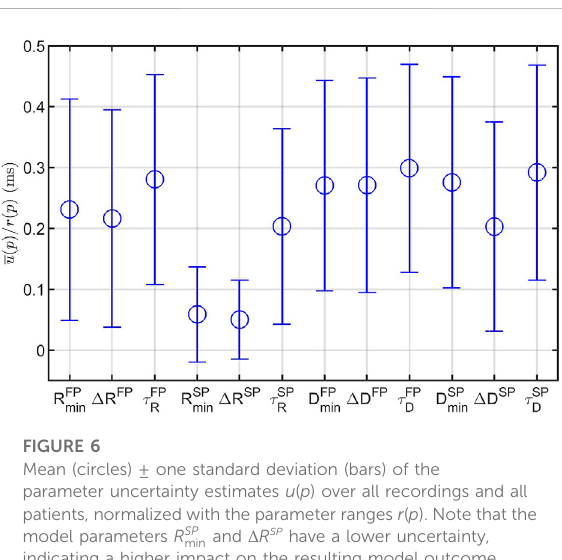
FIGURE 6 Mean (circles) ± one standard deviation (bars) of the parameter uncertainty estimates u ( p ) over all recordings and all patients, normalized with the parameter ranges r ( p ). Note that the